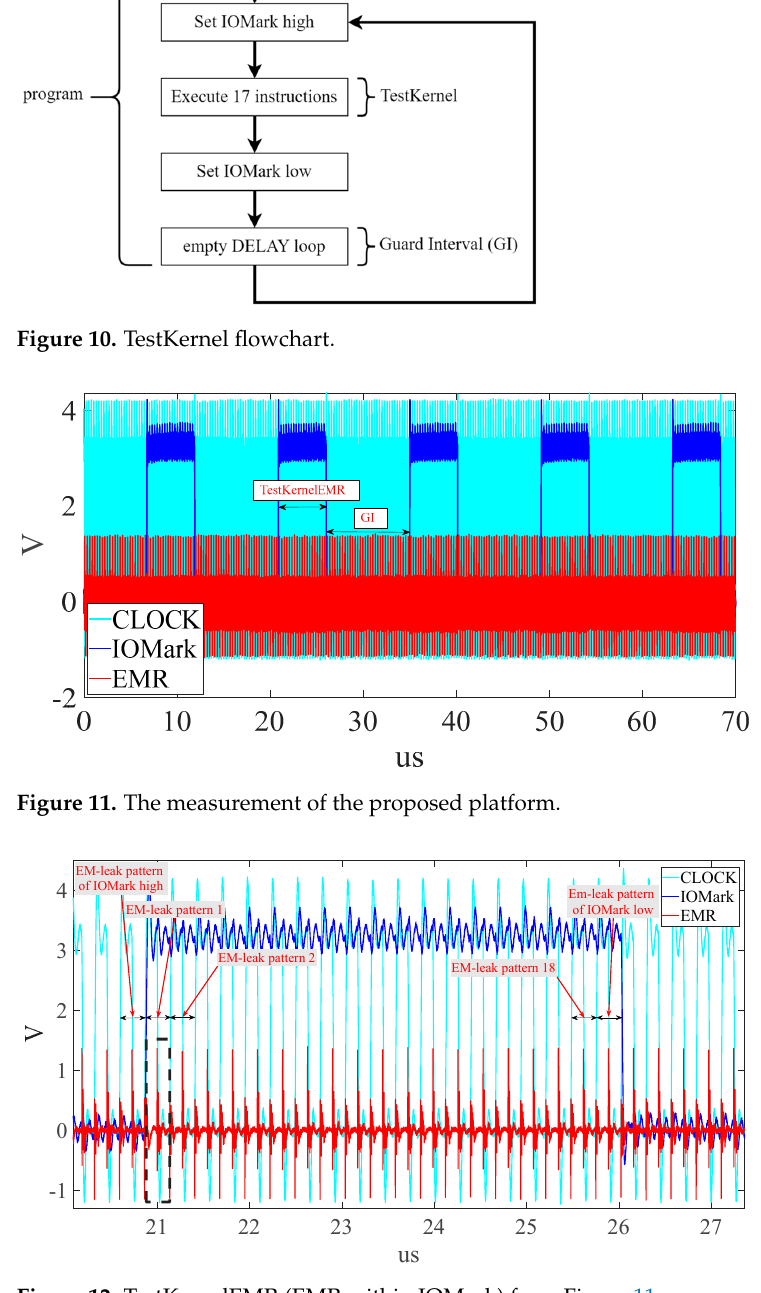
Figure 12. TestKernelEMR (EMR within IOMark) from Figure 11.